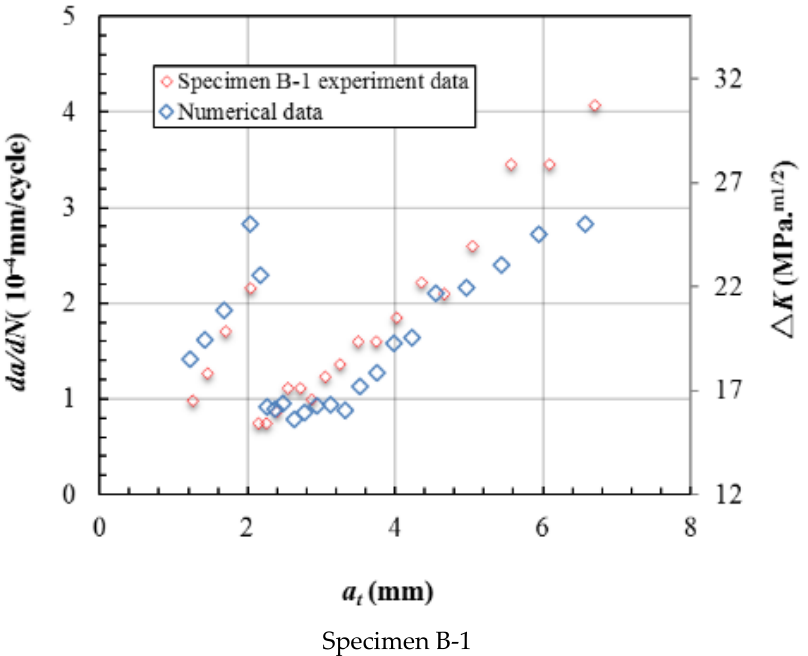
Figure 24. The crack growth rate and Δ K varying with the crack length a t .